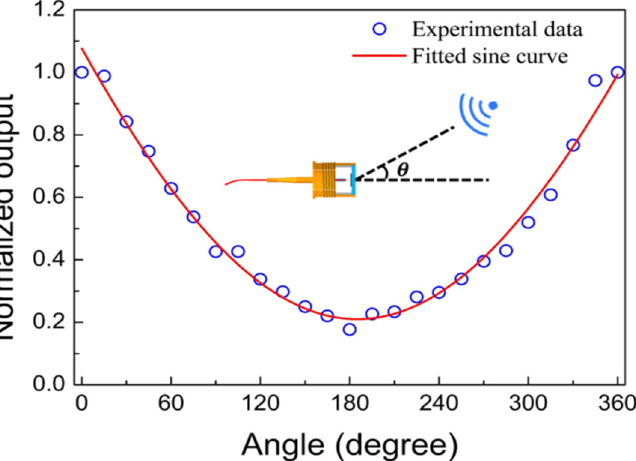
Figure 9. Directional response curve measured for the microphone under test (for comparison, the curve is normalized with the maximum output intensity measured at θ = 0°).